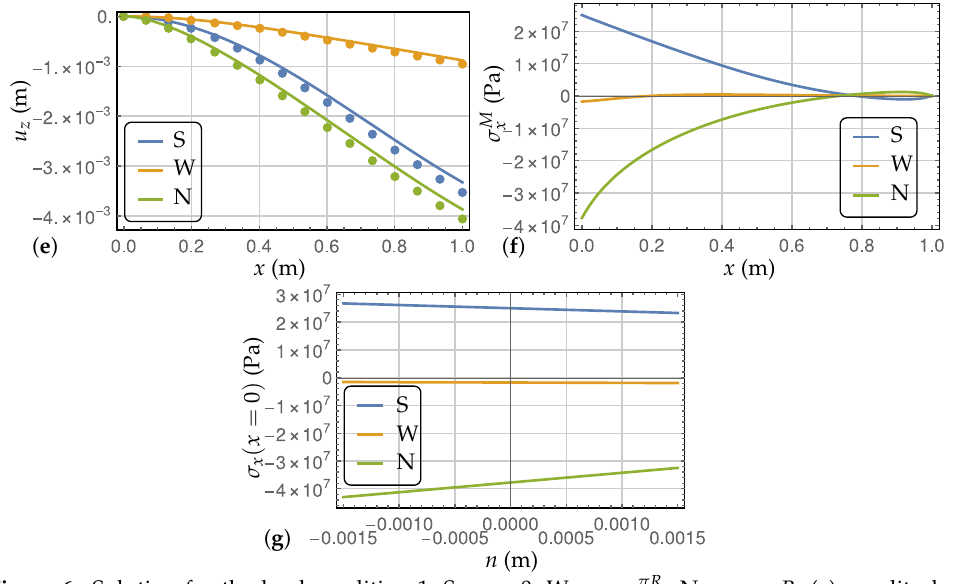
; N: s = π R ; ( a ) amplitudes a j , 2